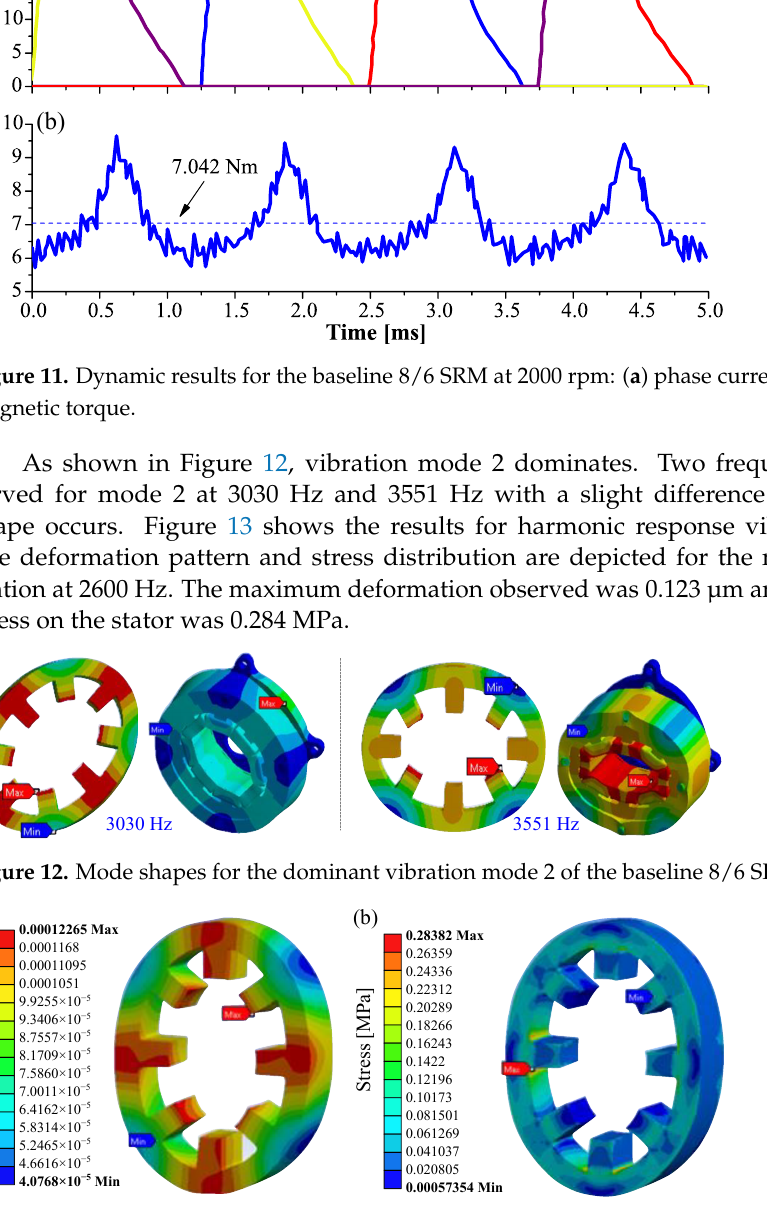
Figure 13. ( a ) Deformation and ( b ) stress contour from the forced vibration simulation at 2600